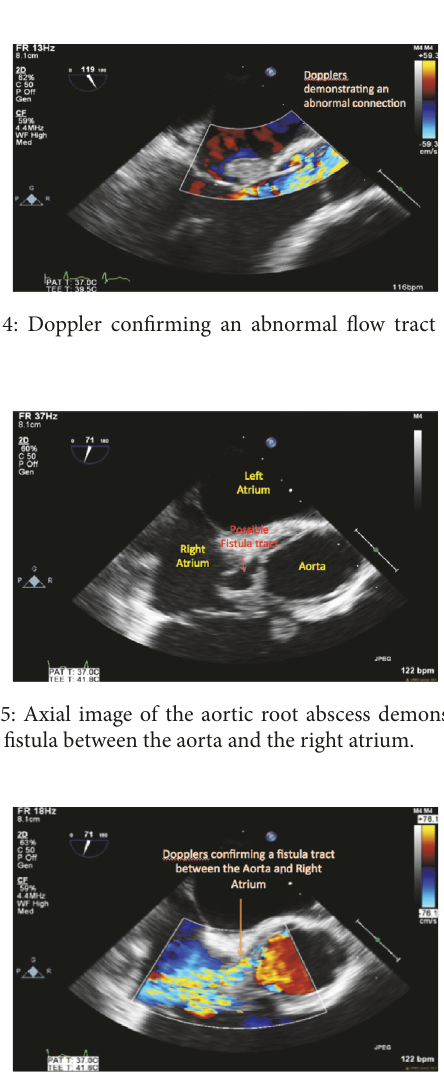
Figure 6: Axial image of the aortic root abscess with Doppler confirming the presence of a fistula between the aorta and the right